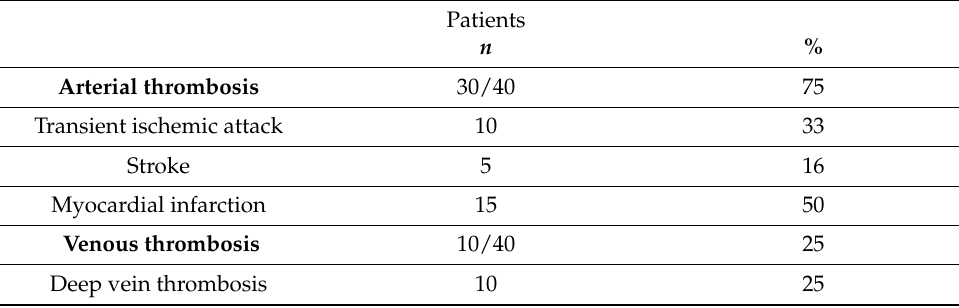
Table 2. Thrombotic events in 40 out of 60 PV